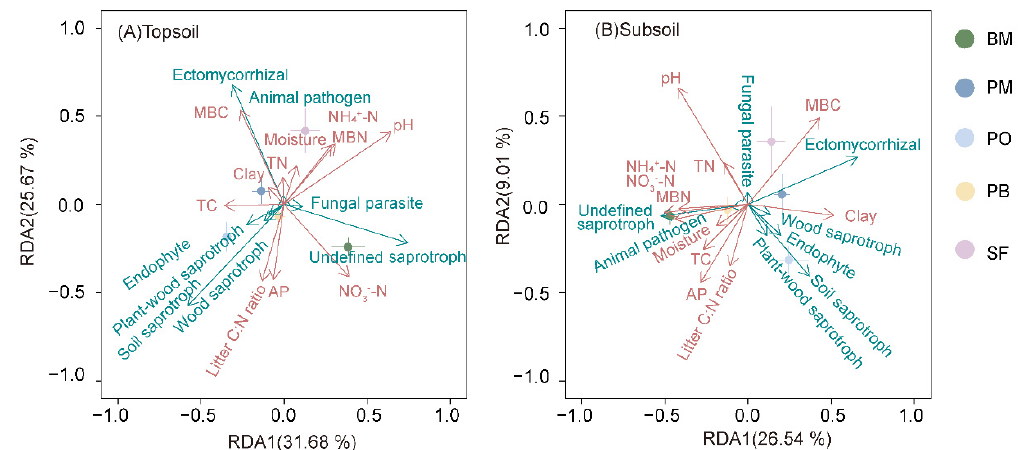
Figure 7. The redundancy analysis of soil guilds with litter and soil physicochemical factors in dif- ferent forest types. ( A ) topsoil; ( B ) subsoil. Broadleaf-oriented transformation, BM; P. massoniana mature plantation, PM; P. massoniana overmature plantation, PO; P. massoniana + local broadleaved trees, PB; secondary forests, SF. Total carbon content, TC; total nitrogen content, TN; ammonium nitrogen, NH 4+ -N; nitrate nitrogen, NO 3 − -N; available phosphorus, AP; microbial biomass carbon, MBC; microbial biomass nitrogen, MBN.